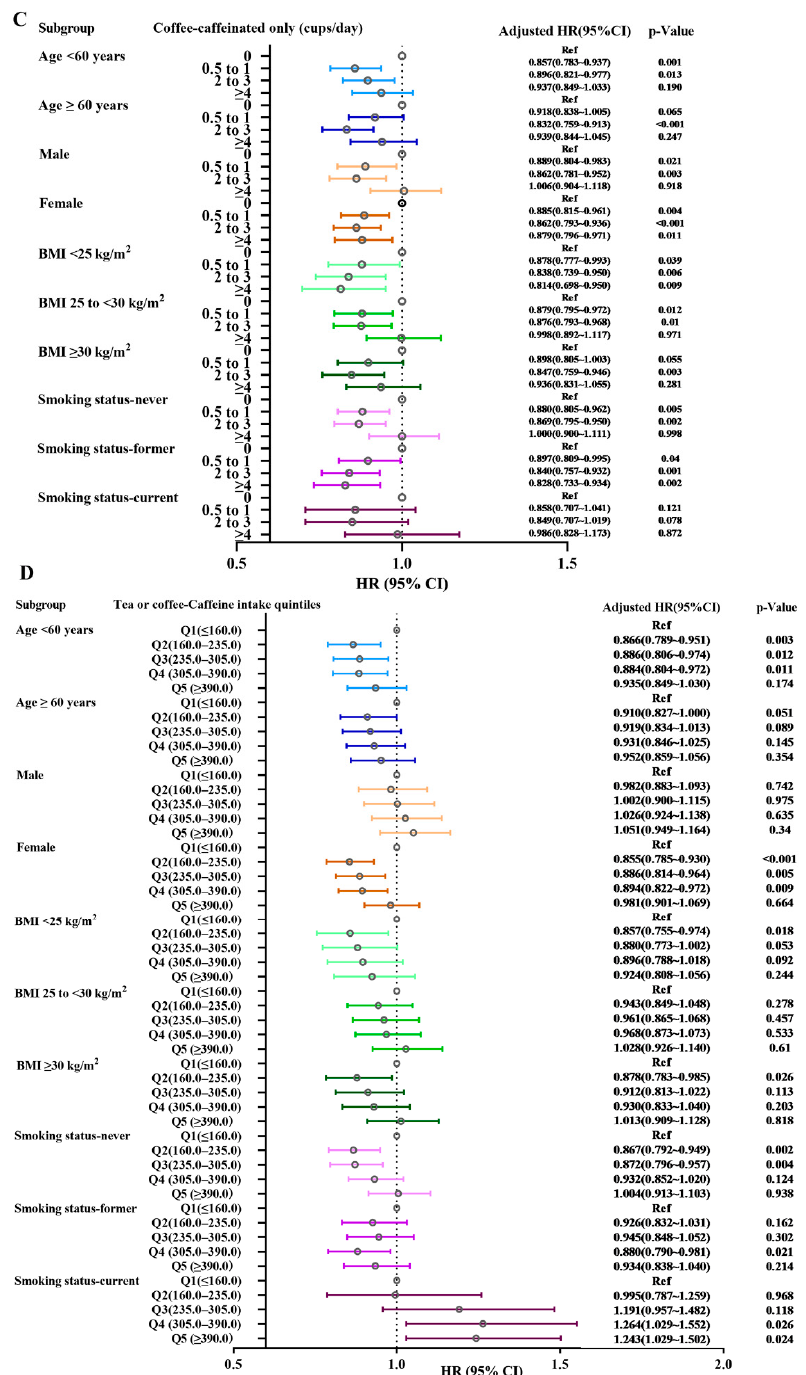
Figure 4. Subgroup analyses according to age, gender, BMI, and smoking status. Summary of hazard ratios and 95% confidence intervals (x-axis) for cups per day categories and linear trend for ( A ) coffee, ( B ) tea, ( C ) caffeinated coffee, and ( D ) combination caffeine intake from coffee and tea for adult-onset asthma. The model is adjusted by age, gender, race, BMI, smoking status, education, and Townsend Index and adjusted for coffee in tea analysis or for tea in coffee analysis. Hatched vertical line indicates the null reference value of ‘1 ′ .